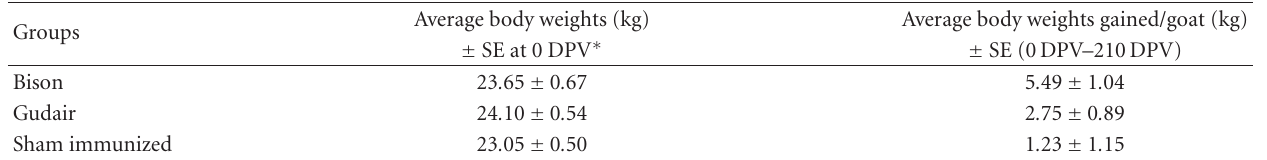
Table 1: Average body weights gained per goat, by vaccinated and “Sham-immunized” groups. Groups